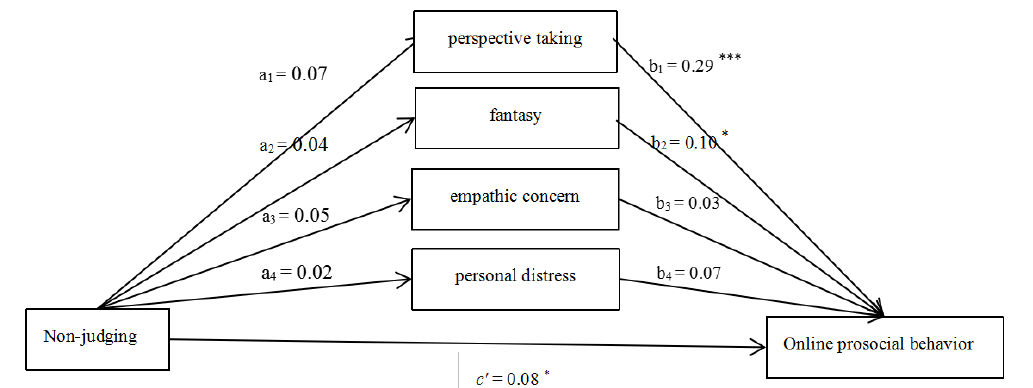
Figure 4. Mediating roles of empathy components (Non-judging as the predictor). Note: * p < 0.05, *** p < 0.001.